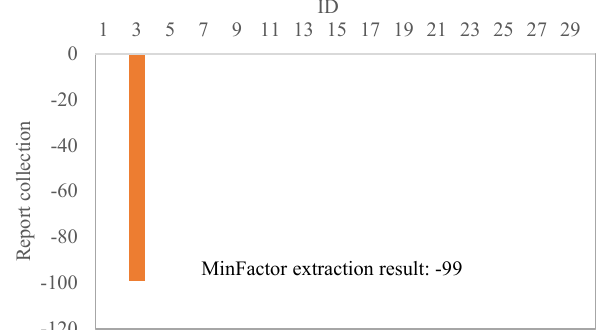
Figure 14. Collection of reports at the edge server in Scenario 3 regarding the proposed scheme.